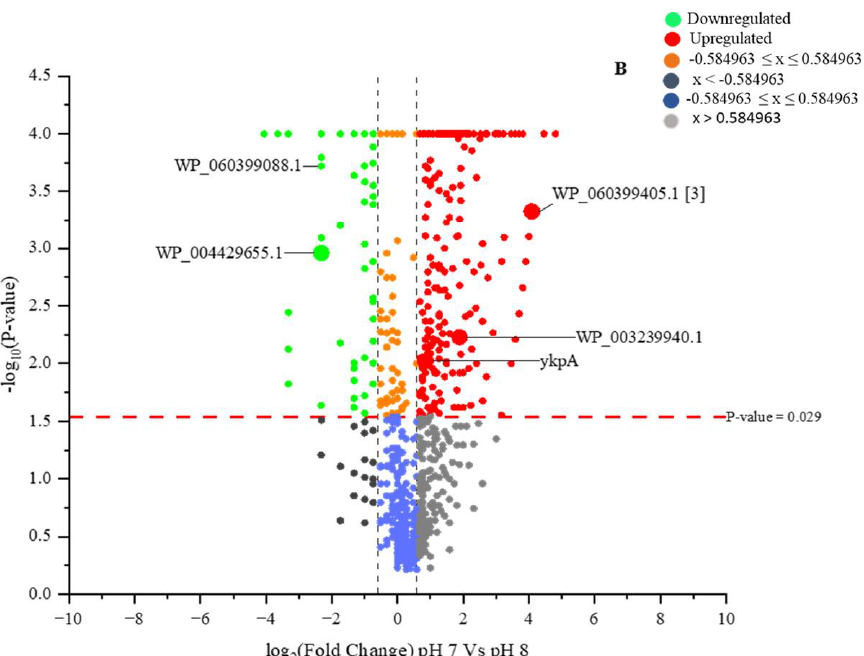
Figure 6. Volcano plots illustrating the distribution of differentially quantified proteins of B. subtilis CFS as − log10 (Benjamini–Hochberg-adjusted p -values) plotted against log2 (fold change) for ( A ): pH 7 vs. pH 5 and ( B ): pH 7 vs. pH 8. The non-axial black dashed vertical lines represent a ± 1.5-fold change, while the horizontal red dashed line indicates the significance threshold (before logarithmic transformation) for ( A ): p ≤ 0.002 and ( B ): p ≤ 0.013.